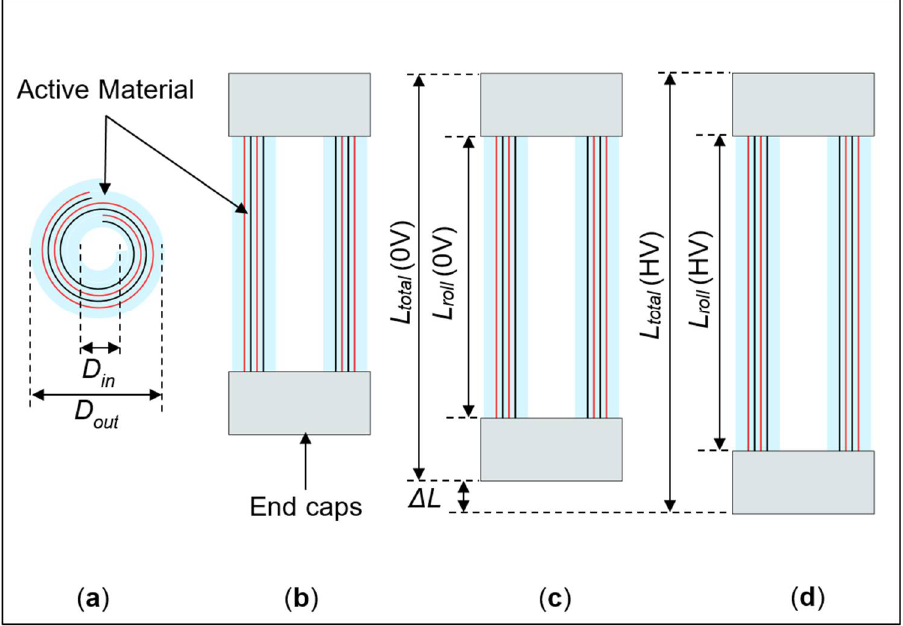
Figure A1. Dimensions on a diagram of a generic RDEA for determining normalized performance metrics. Cross-sectional cut ( a ) and longitudinal cut ( b ) of the unstretched roll, longitudinal cut of the pre-stretched roll at 0 V ( c ), and longitudinal cut of the actuated roll at high voltage ( d ).